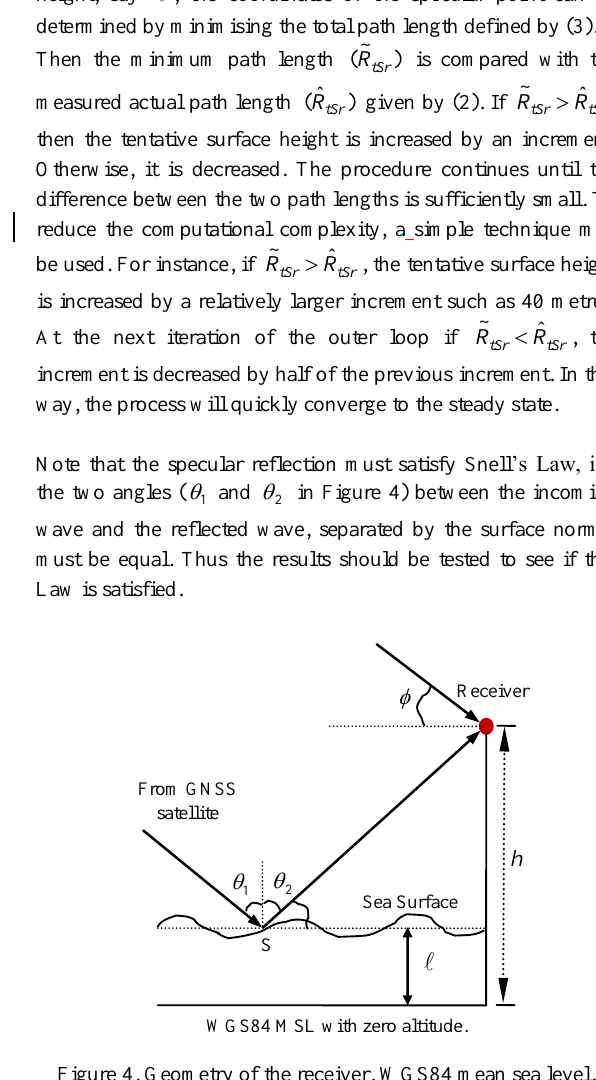
Figure 4. Geometry of the receiver, WGS84 mean sea level, rough sea surface, direct and reflected signal